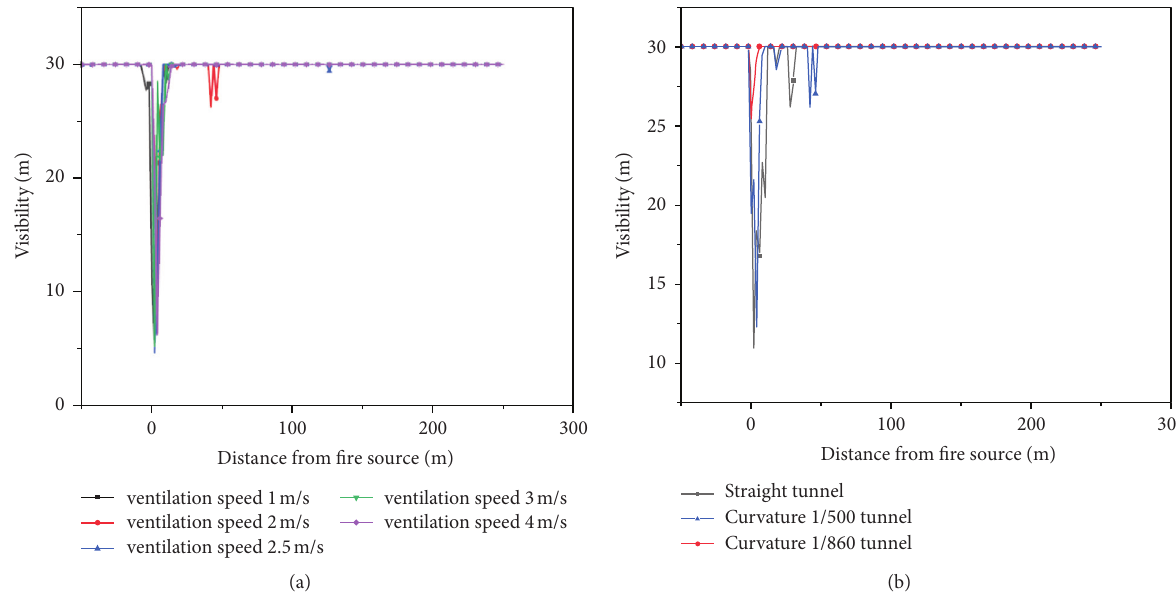
Figure 12: Longitudinal distribution of visibility at eye height. (a) Visibility change curve at human eye height under different longitudinal ventilation speeds. (b) Visibility curve at eye height of 2m/s ventilation